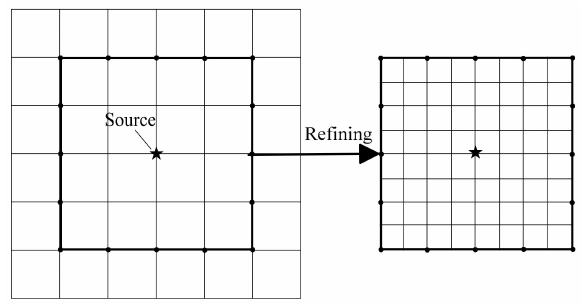
Figure 2. Sketch map of the double-grid technology. The star represents the source, the bold lines represent the boundary of the refined area, and the bold dots represent the original grid nodes on this